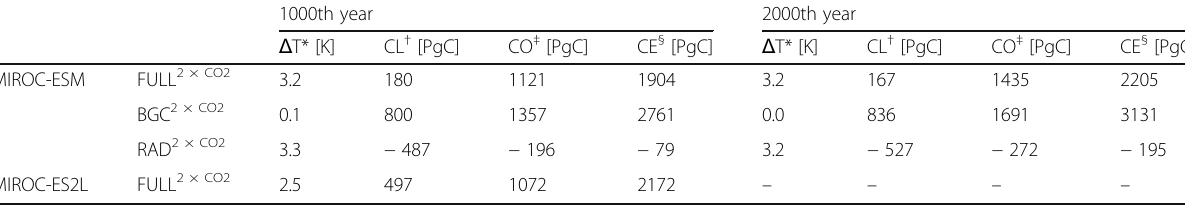
Table 2 The simulation results of FULL 2 × CO2 , BGC 2 × CO2 , and RAD 2 × CO2 by MIROC-ESM and